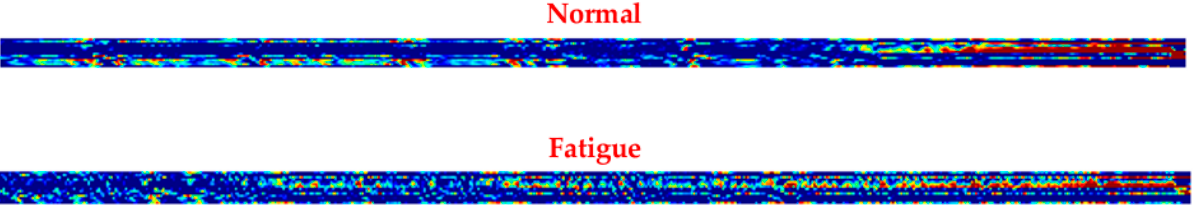
Figure 16. Visualization of activations from the first convolutional layer for a sample of normal and fatigue states (region E).